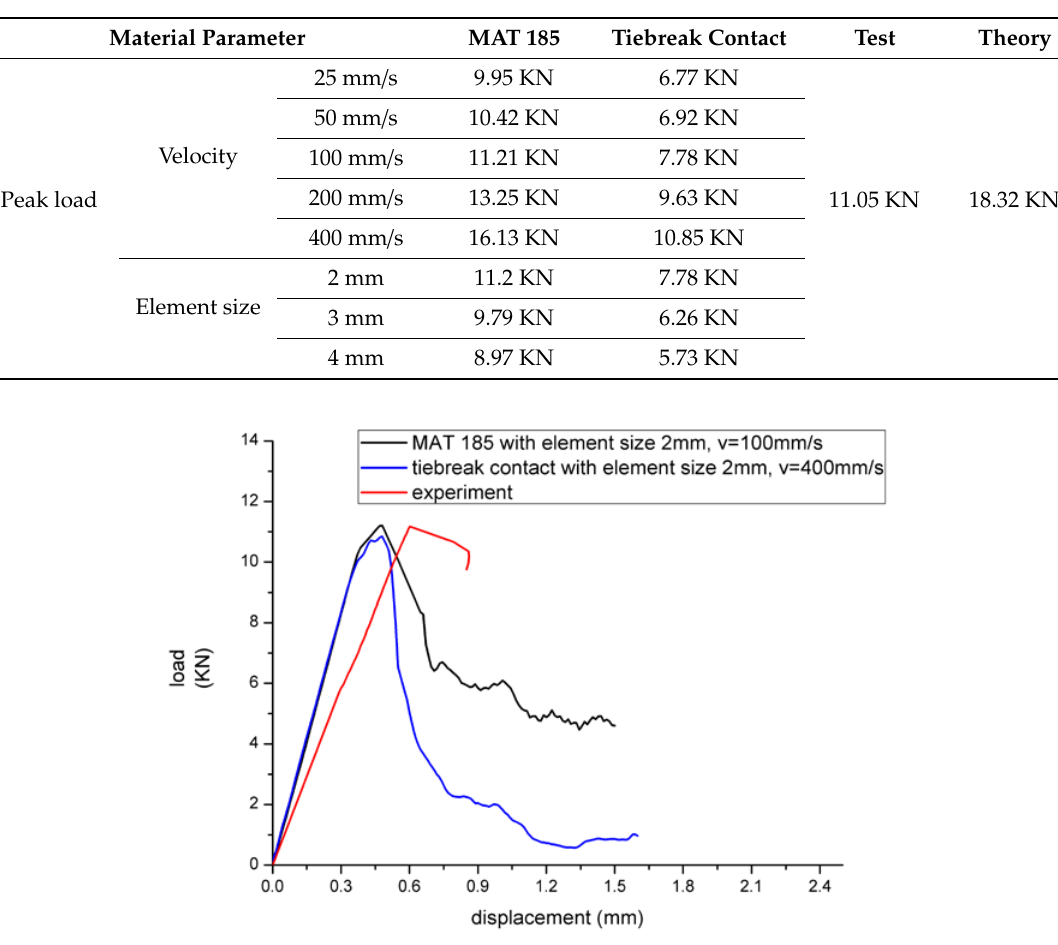
Figure 13. Comparison of simulation result and experiment result.